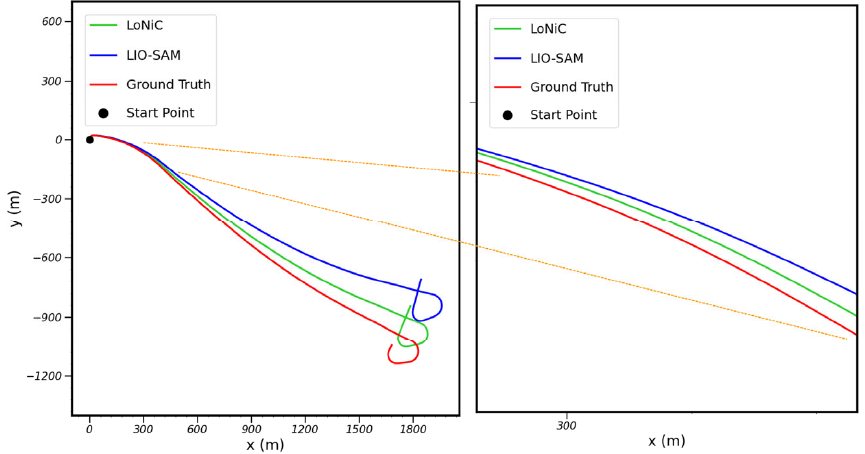
Figure 11. Trajectory comparison of sequence 01 on the KITTI dataset.